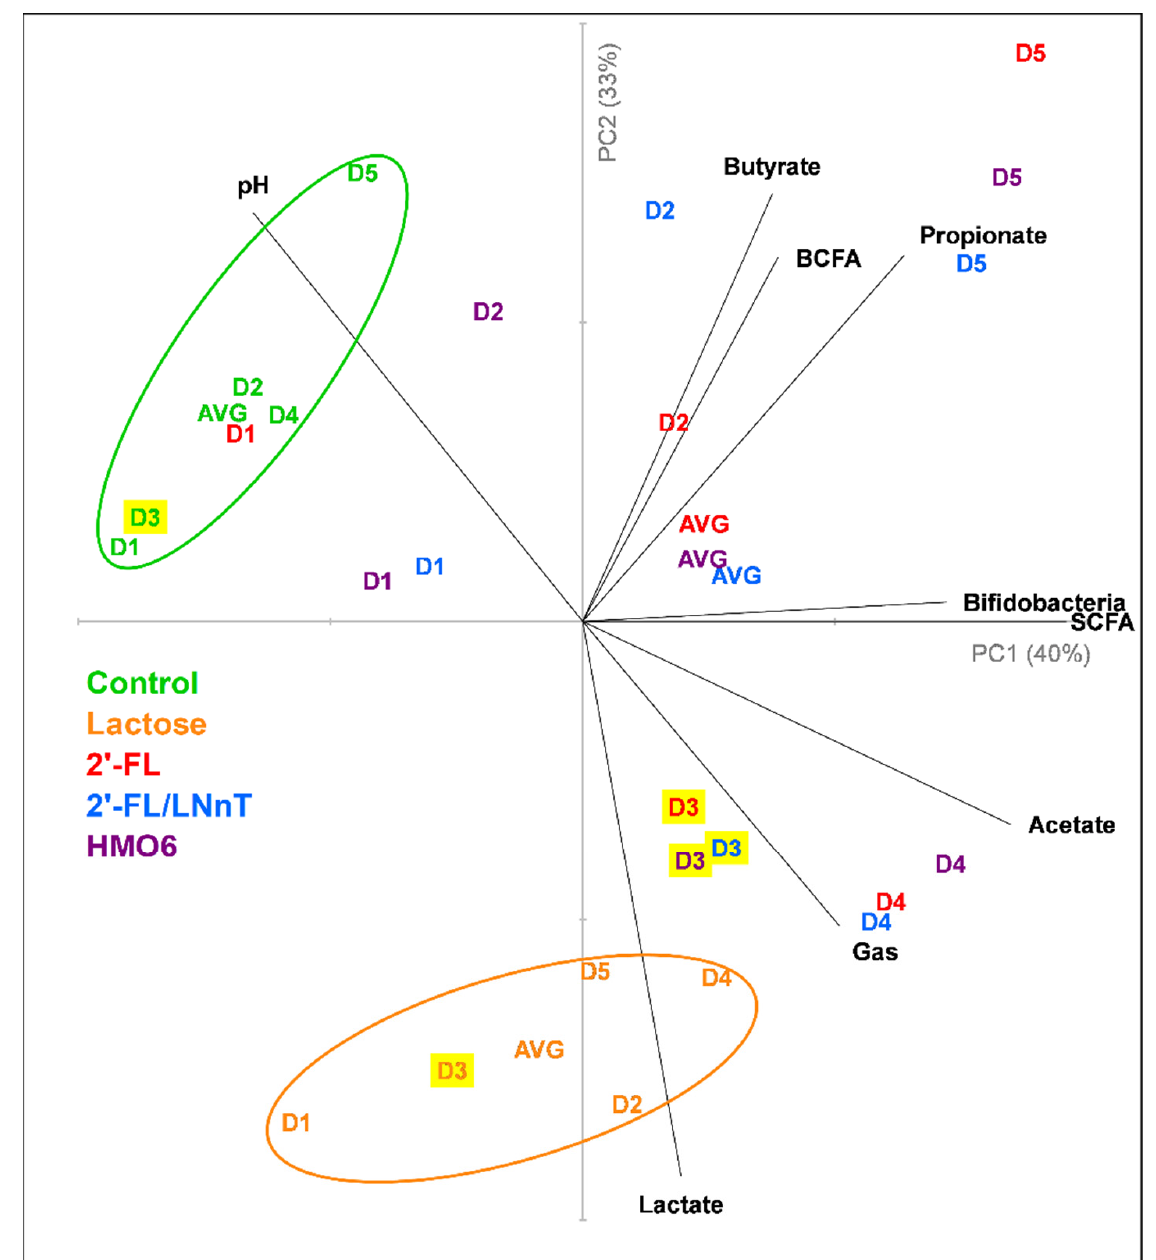
Figure 3. Principal component analysis plots representing metabolic data (pH, Gas, Acetate, Propionate, Butyrate, Lactate, BCFA, and total SCFA) and bifidobacteria levels obtained for control, lactose, 2 ′ -FL, 2 ′ -FL/LNnT, and HMO6 after 48 h of incubation with fecal microbiota from five breastfed infant donors. BCFA= branched-chain fatty acid; SCFA= short-chain fatty acid; 2 ′ -FL = 2 ′ -fucosyllactose; LNnT = lacto-N-neotetraose; D = donor; PC = principal component; AVG = average. Ellipses represent a 95% confidence interval and are only included for the control and lactose, due to the widespread and donor-dependent response for 2 ′ -FL, 2 ′ -FL/LNnt, and HMO6.